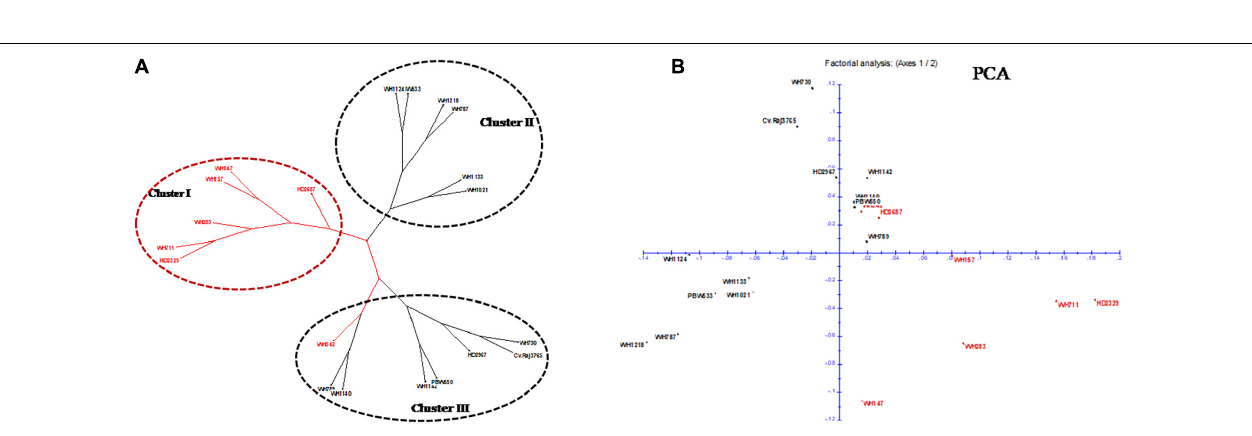
FIGURE 4 | Phylogenetic studies of wheat genotypes with heat-responsive miRNA-SSRs. (A) Dendrogram showing clustering of 20 wheat genotypes using polymorphic miRNA-SSR markers. Red color indicates heat-susceptible wheat genotypes, and black color indicates heat-tolerant wheat genotypes. (B) 2-D plot of principal coordinate analysis (PCA) for all 20 wheat genotypes. Red and black colors were used for heat-susceptible and heat-tolerant genotypes, respectively.